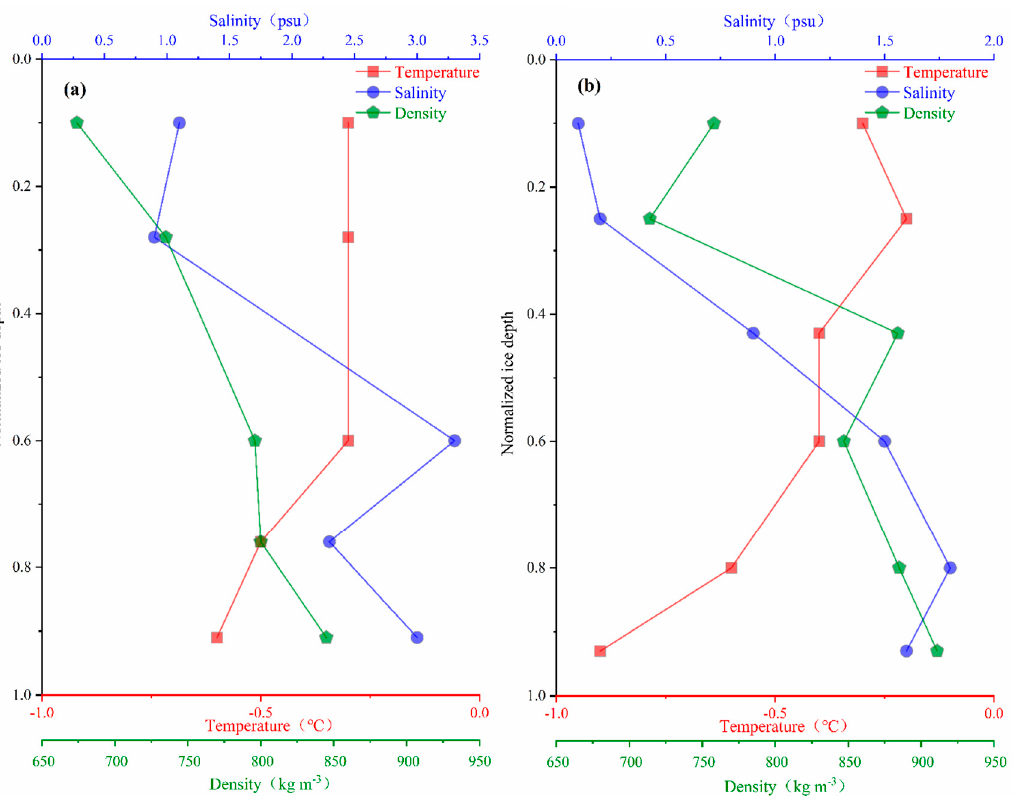
Figure 2. Sea ice salinity, temperature, and density against normalized depth for ( a ) FYI (20 August 2016) and ( b ) MYI (18 August 2016) during the melt season.